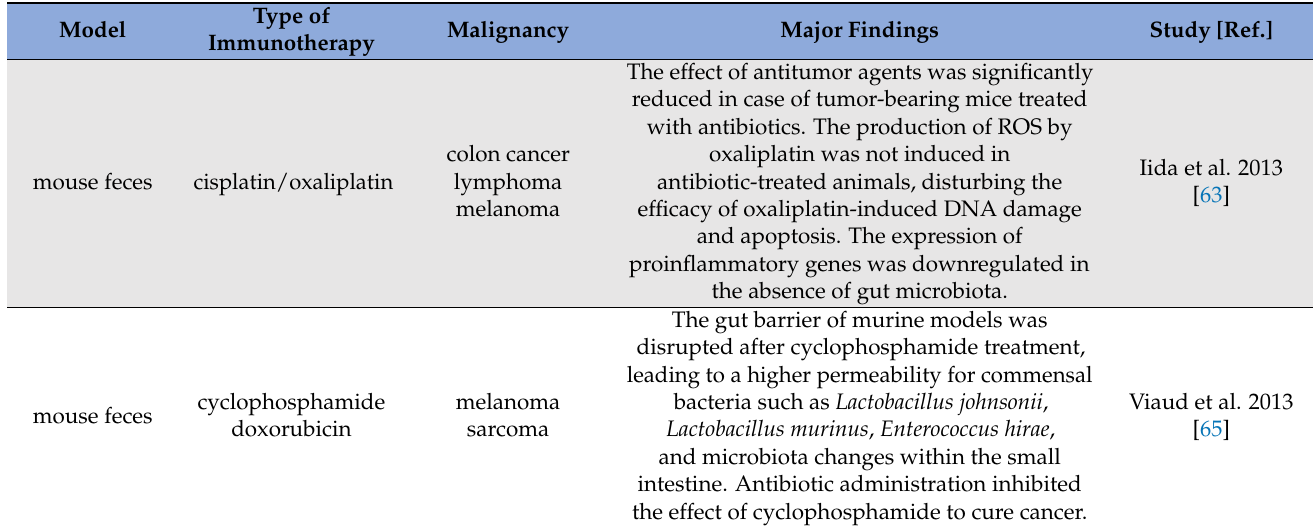
Table 1. The relationship between gut/intratumoral microbiome and chemotherapy. The table summarizes the major findings from preclinical and clinical